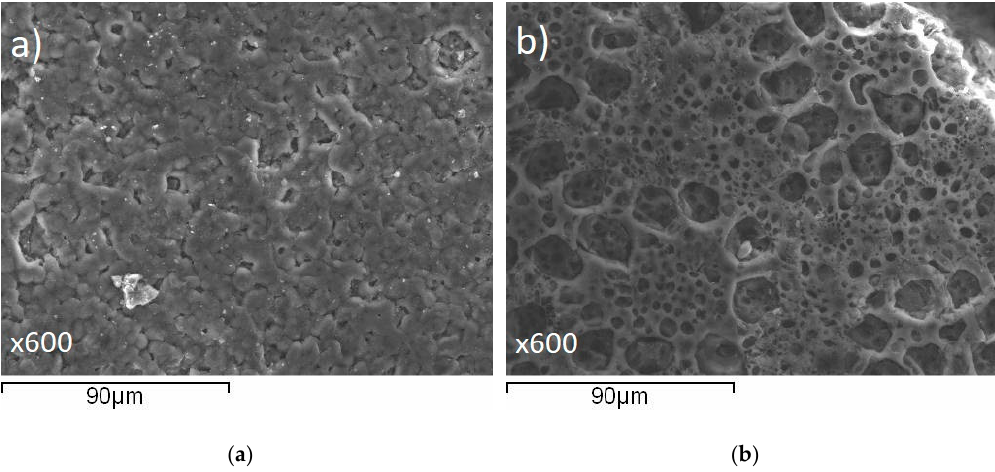
Figure 9. Microscopy images (at ×600 magnification) of the PVIB-10 membrane after testing in a lignin-oxidising electrolyser: ( a ) SEM image of an area of the membrane surface that was apparently undamaged to the naked eye and ( b ) SEM image of an area of the membrane surface where damage was already evident by eye.